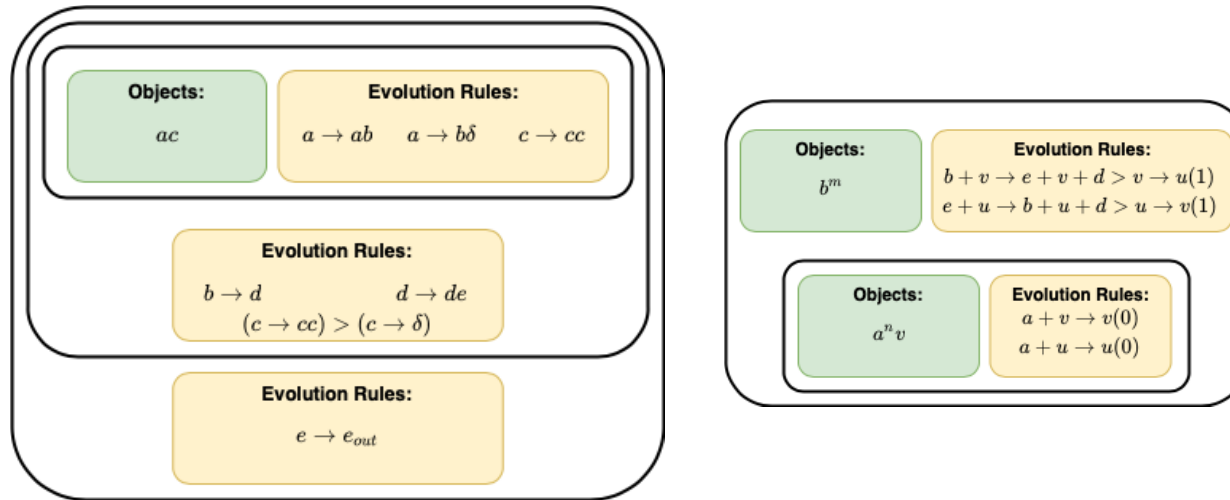
Figure 4. The graphical representation of a P system which outputs square numbers into the environment [25] ( left ) and multiplication [33] ( right